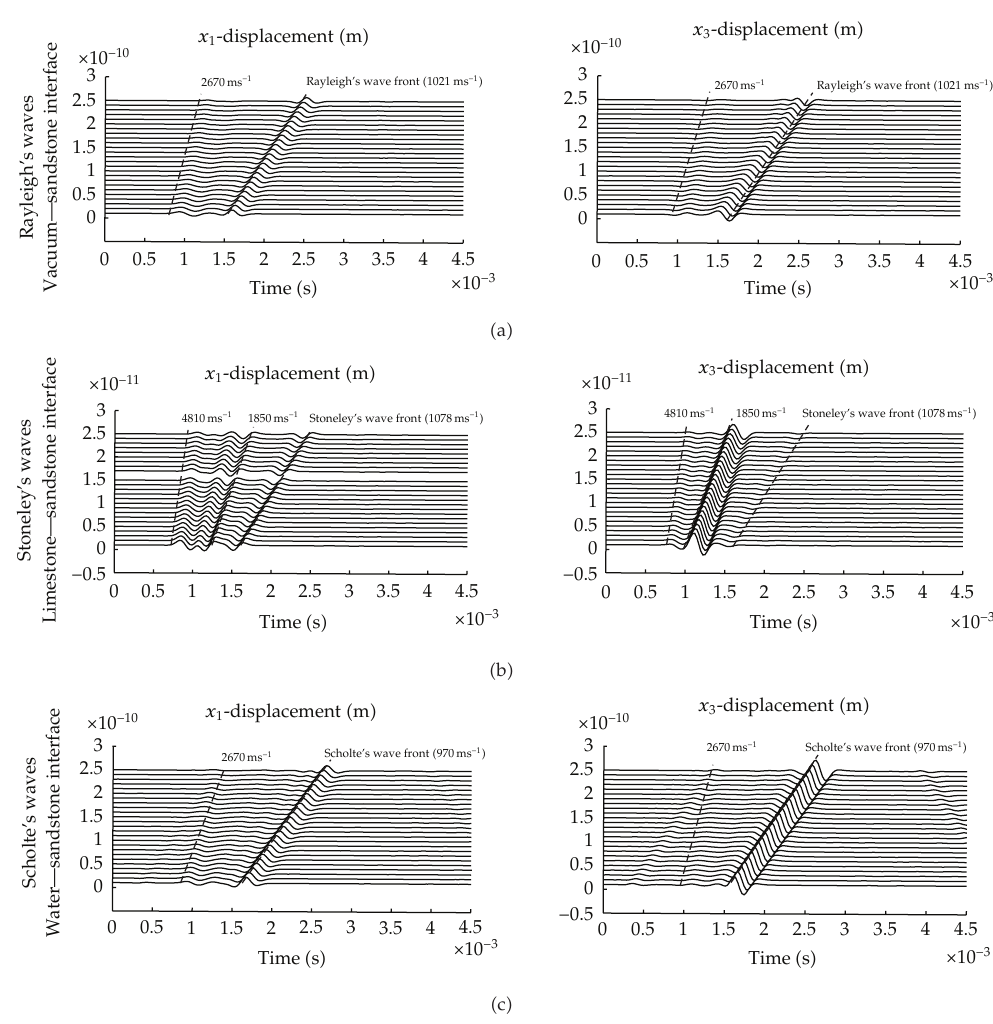
Figure 4: Synthetic seismograms for three di ff erent interfaces. (cid:2) a (cid:5) Vacuum-solid interface; (cid:2) b (cid:5) solid-solid interface, and (cid:2) c (cid:5) fluid-solid interface. x 1 (cid:2) left (cid:5) and x 3 (cid:2) right (cid:5) components of displacement are plotted. Materials 1 from the Table 1 are used for the